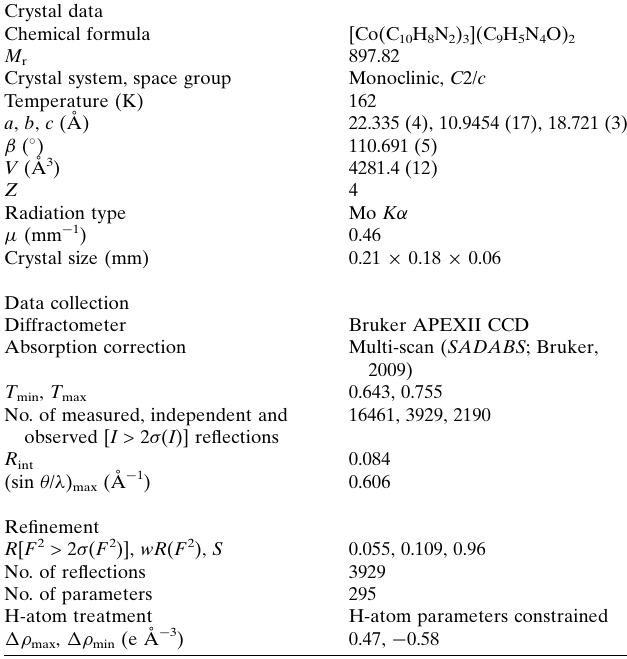
Table 3 Experimental details. Crystal data Chemical